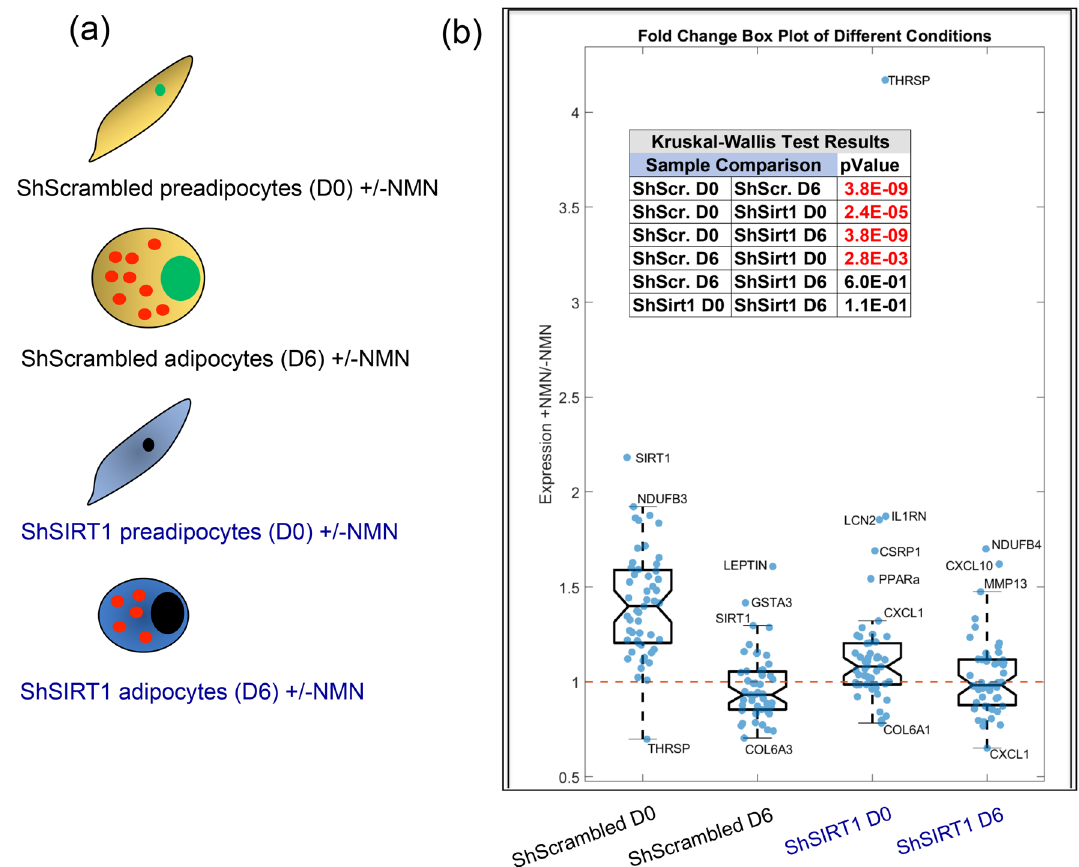
Figure 8. Supplementation with NMN elicited SIRT1-dependent and -independent changes in gene-expression during 3T3-L1 adipogenesis. ( a ) NMN-induced changes in expression of the indicated genes were analyzed in four experimental conditions: ShScrambled preadipocytes (ShScrambled D0), ShScrambled adipocytes (ShScrambled D6), ShSIRT1 preadipocytes (ShSirt D0) and ShSIRT1 adipocytes (ShSirt1 D6). ( b ) Shown are box plots indicating the effects of NMN on gene-expression in each of the 4 conditions, as indicated. Individual blue dots represent the ratio of +NMN/−NMN for each gene. The notched box shows the interquartile range (25th–75th percentile) and the central line within the box represents the median. The whiskers extend to points not considered outliers and data points outside the whiskers were considered quartiles. The dashed red line is set at 1 and the inset table shows the results of Kruskal–Wallis testing on each of these groups. Some of the molecules whose expression was significantly affected by NMN supplementation are also were significantly higher in SIRT1-depleted preadipocytes, expression gradually declined by D2, but increased again to levels that were comparable to ShScrambled adipocytes (Fig. 7d). The data suggested that SIRT1 pro- moted NMNAT2 expression during 3T3-L1 differentiation and constitutively repressed NMNAT1/3 expression in preadipocytes. The observation that SIRT1-depletion downregulated NMNAT2 and upregulated NMNAT1/3 prompted us to investigate the functional impact of NAD + -signaling during 3T3-L1 differentiation. We supplemented ShScram- bled and ShSIRT1 (pre)adipocytes with the NAD + precursor NMN (1 mM) throughout the process of differen- tiation. Quantification of cellular NAD + levels indicated that supplementation with 1 mM NMN significantly increased total intracellular NAD + levels (Fig. 7e,f). Oil Red O staining of adipocytes at Day 6 post-differentiation suggested that supplementation with NMN did not elicit any overt effects of triglyceride synthesis (Fig. 7g). Next, we comprehensively profiled NMN-induced changes in gene-expression in ShScrambled and ShSIRT1 (pre) adipocytes during differentiation. This analysis was focused on a specific set of molecules (Supplementary Fig- ure S3), including adipokines (leptin, adiponectin, LCN2), chemokines (CXCL1, CXCL10), extracellular matrix components (MMP3, MMP13, Col6A1, Col6A3), and transcription factors (including SREBF1c and PGC-1α) and their transcriptional targets (FAS, SCD1, AGPAT2, NDUFB4/6/8). Some molecules whose expression levels were altered in the proteomics dataset were also included (THRSP, TRPM7, GCHFR, TBC1D10A). Because NMNAT1-3 were dysregulated upon SIRT1-depletion, effects of NMN on their expression levels in ShScrambled and SIRT1-depleted (ShSIRT1) (pre)adipocytes were also investigated. NMN-induced changes in mRNA levels of the selected gene-set were quantified in ShScrambled and ShSIRT1 (pre)adipocytes. Transcriptional changes in response to supplementation with 1 mM NMN were tested in four different conditions: ShScrambled preadipocytes (ShScrambled D0), ShScrambled adipocytes (ShScrambled